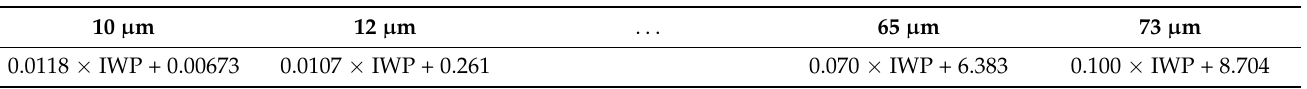
Table 2. The selected equations from the fitted piecewise functions at 664.0 ± 4.2 GHz, the table header is labeled D me for each selected